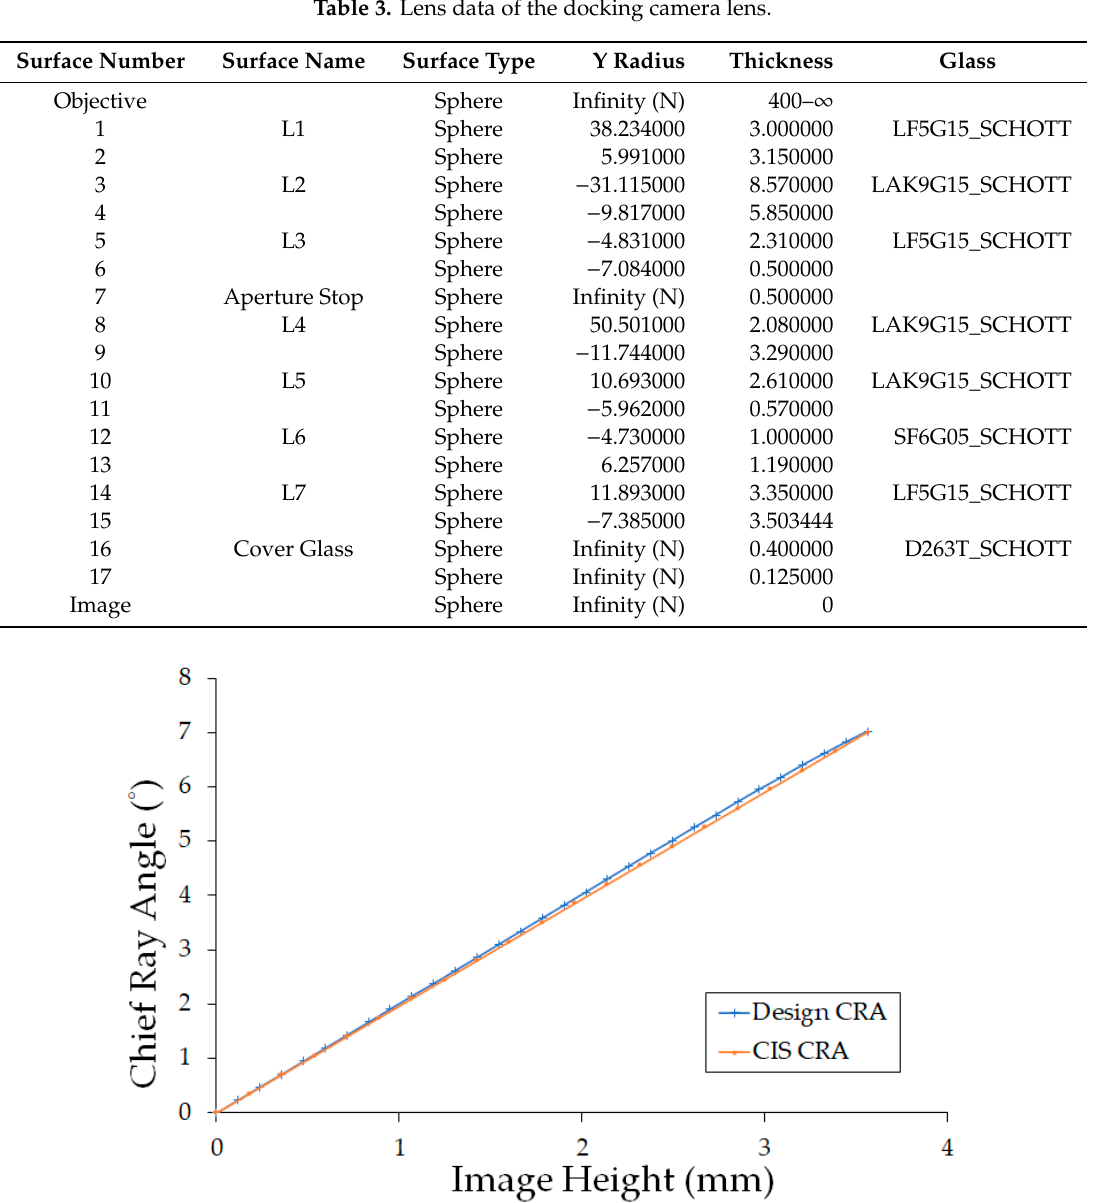
Figure 3. Chief ray angle (CRA) curve of the designed value and specified value of MT9P031 CIS.